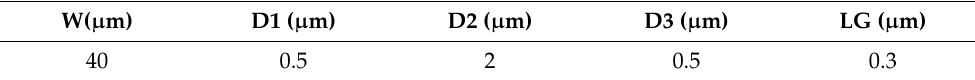
Figure 3. TLP I-V characteristics of: ( a ) 6-NMOSs-chain ULVTSCR and LVTSCR, ( b ) ULVTSCRs with N = 4, 5, 6, and 7. Table 1. Geometrical dimensions of tested ULVTSCR and LVTSCR.